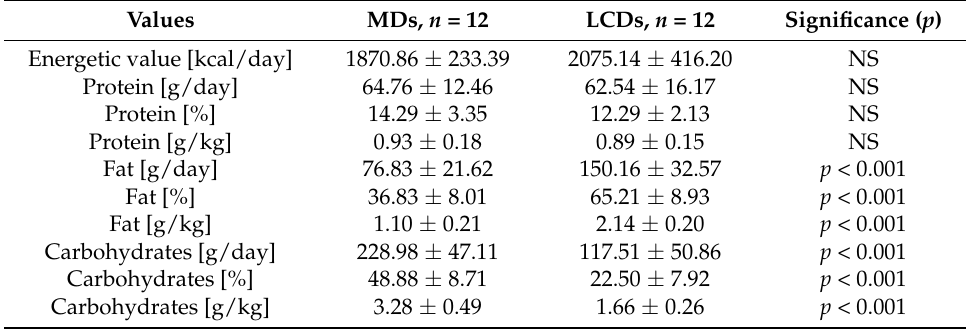
Table 2. Daily energy and macronutrient intakes calculated from 7-day observation of participants in the low carbohydrate diets (LCDs) and mixed diets (MDs)